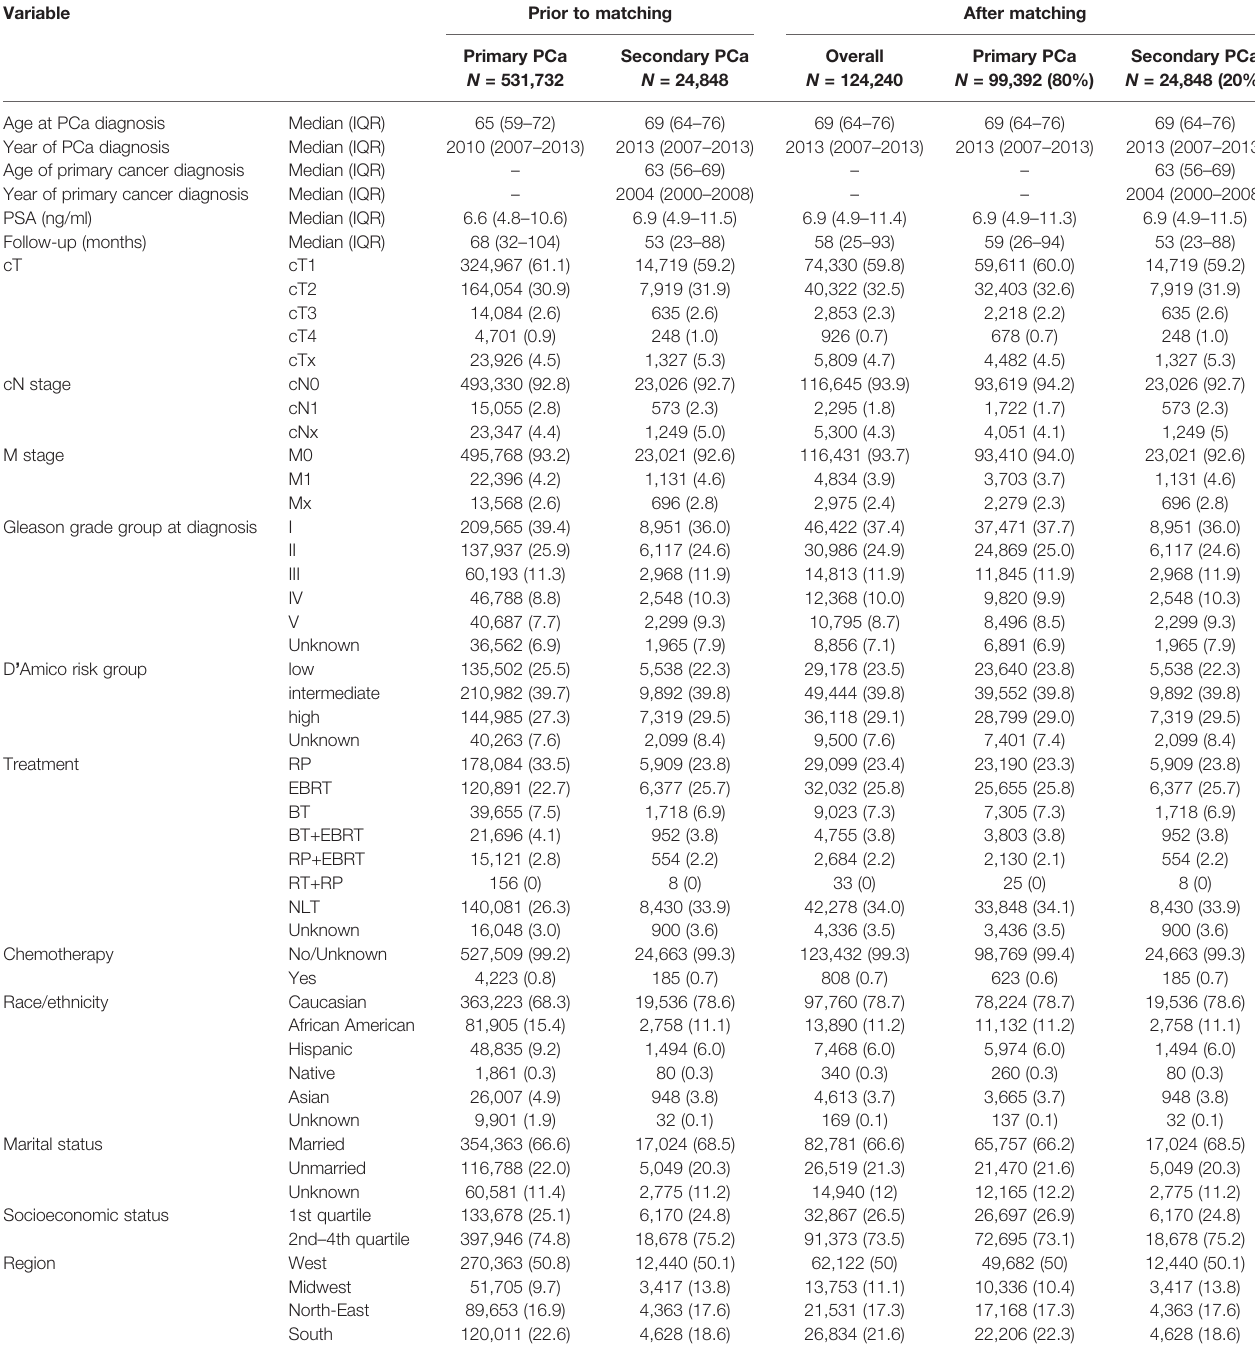
TABLE 1 | Descriptive characteristics prior to matching and after matching for age at prostate cancer diagnosis, year of prostate cancer diagnoses, race/ethnicity, treatment type, and TNM stage for primary and secondary prostate cancer patients.